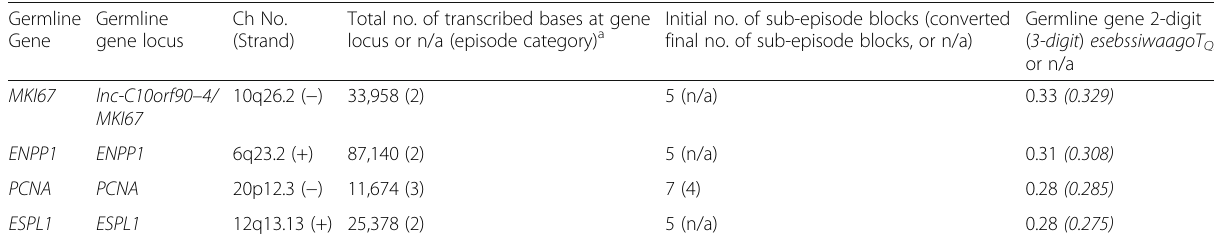
Table 15 ( − ) and (+) strand chromatin MKI67 , ENPP1 , PCNA and ESPL1 cell proliferation marker gene esebssiwaagoT Q s for pressuromodulation